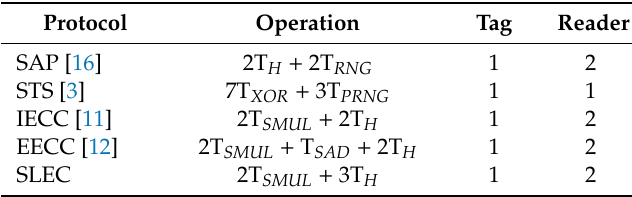
Table 4. Comparison of computation